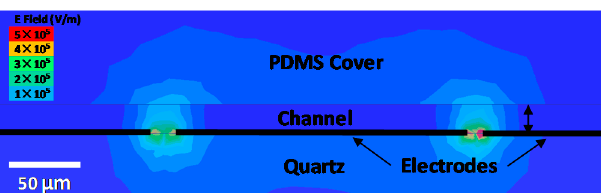
Figure 5. Distribution of electric field simulated at 5 GHz along the cross section through the protrusion in the ground electrode as indicated by A’–A” in Figure 1c, with DI water in the microfluidic channel. The field is stronger on the right side because of the protrusion.